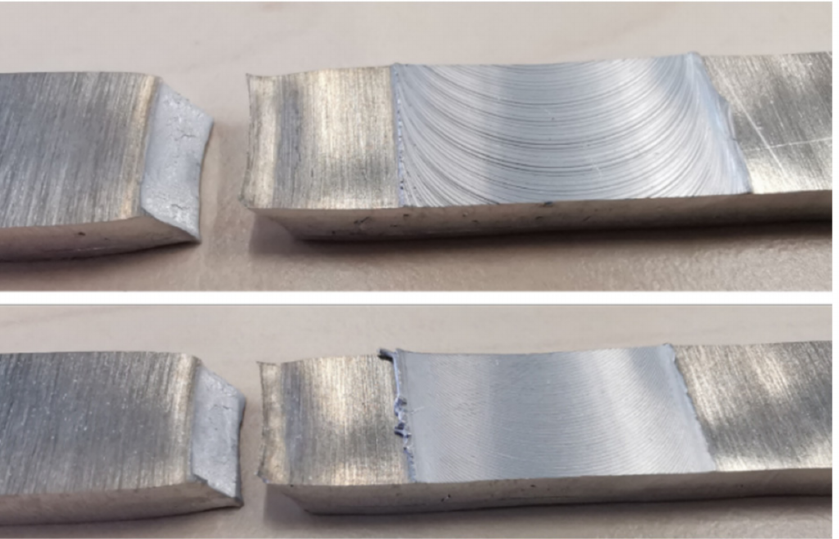
Figure 20. Exemplary illustration of fractures outside the welding seam using tools 3-20-8 ( top ) and 4-20-8 ( bottom ) at a joint gap width of 0.9 mm; n = 300, f =